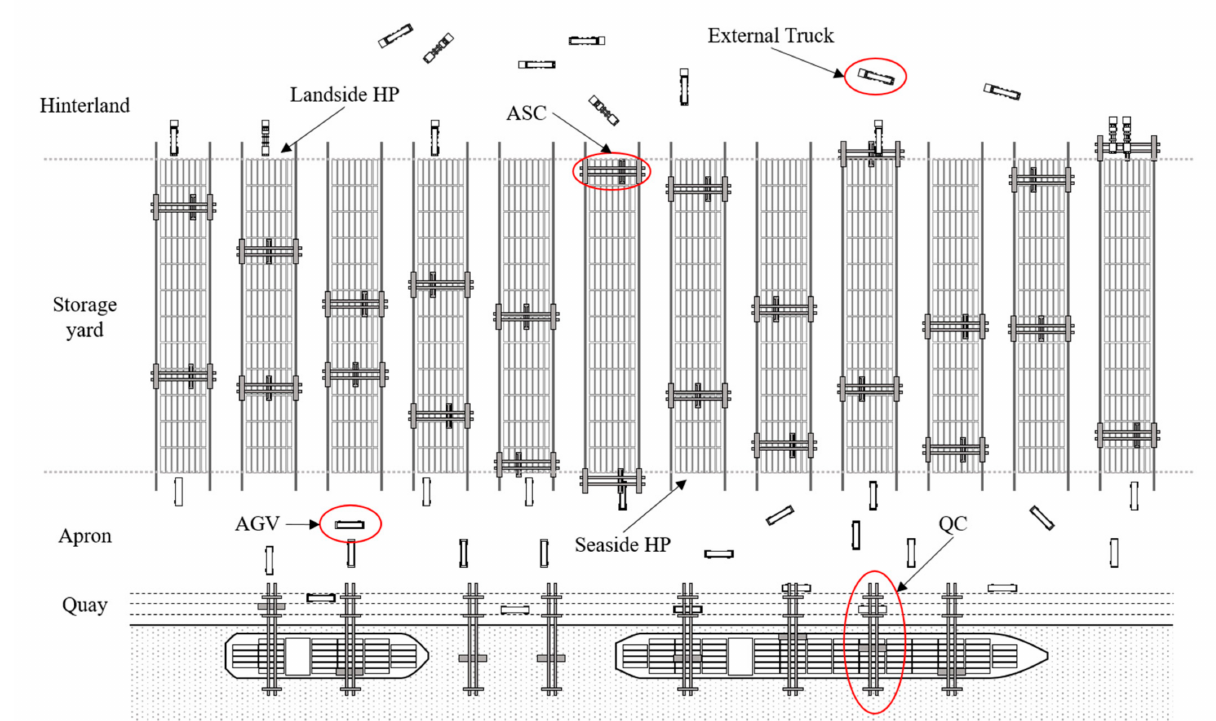
Figure 1. Layout of an automated container terminal (adapted from